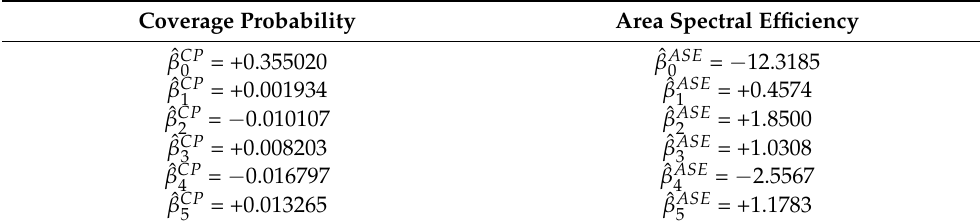
Table 5. Parameter values of the finalized models.